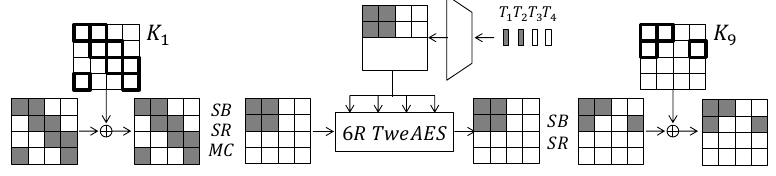
Figure 11: TweAES : Extension to 8-round Key